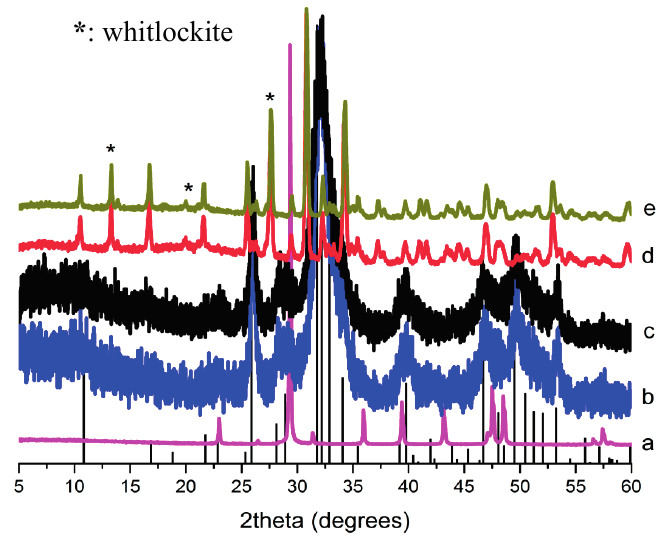
Figure 1. XRD Patterns of (a) calcite from waste eggshell; hydroxyapatite (Hap) produced using (b) Na 2 HPO 4 and (c) H 3 PO 4 (HAp284PA); and the calcined HAp284PA at (d) 700 °C and (e) 950 °C; bars: HAp reference (ICSD-PDF2: 01-084-1998).